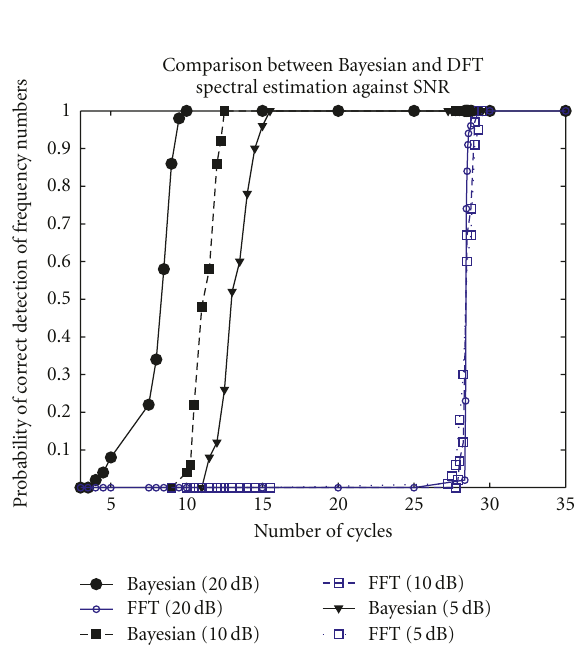
Figure 2: Comparison of probability of correct detection of frequency numbers using Bayesian inference and DFT